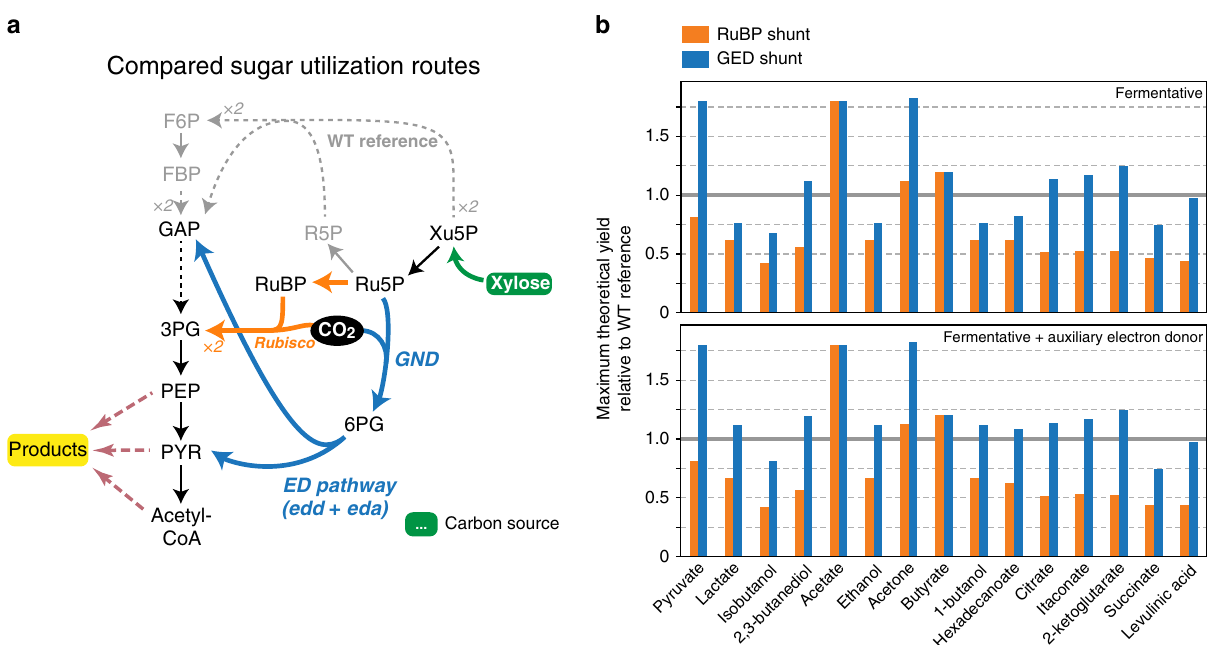
Fig. 5 Rerouting sugar fermentation via the GED shunt can increase product yields. In this example, we chose xylose as the sugar substrate, due to its growing relevance as a renewable feedstock derived from lignocellulosic wastes. An additional analysis with glucose as the fermentation feedstock is shown in Supplementary Fig. 4. a An overview comparing xylose utilization routes: Canonical utilization (gray) via the pentose phosphate pathway and glycolysis; the GED shunt (blue); and a linear pathway based on carboxylation by Rubisco (RuBP shunt, orange). b Maximal theoretical yields of 15 fermentation products are shown relative to the WT reference, as calculated by fl ux balance analysis. Presented values are normalized to the product yield from canonical sugar utilization (pentose phosphate pathway and glycolysis). Most products are predicted to require the secretion of other organic compounds (e.g., acetate, formate) to achieve a balancing of reducing equivalents or support ATP biosynthesis. Of the products shown in the fi gure, only butyrate is predicted to be produced without byproducts. Source data underlying b are provided as a Source Data fi